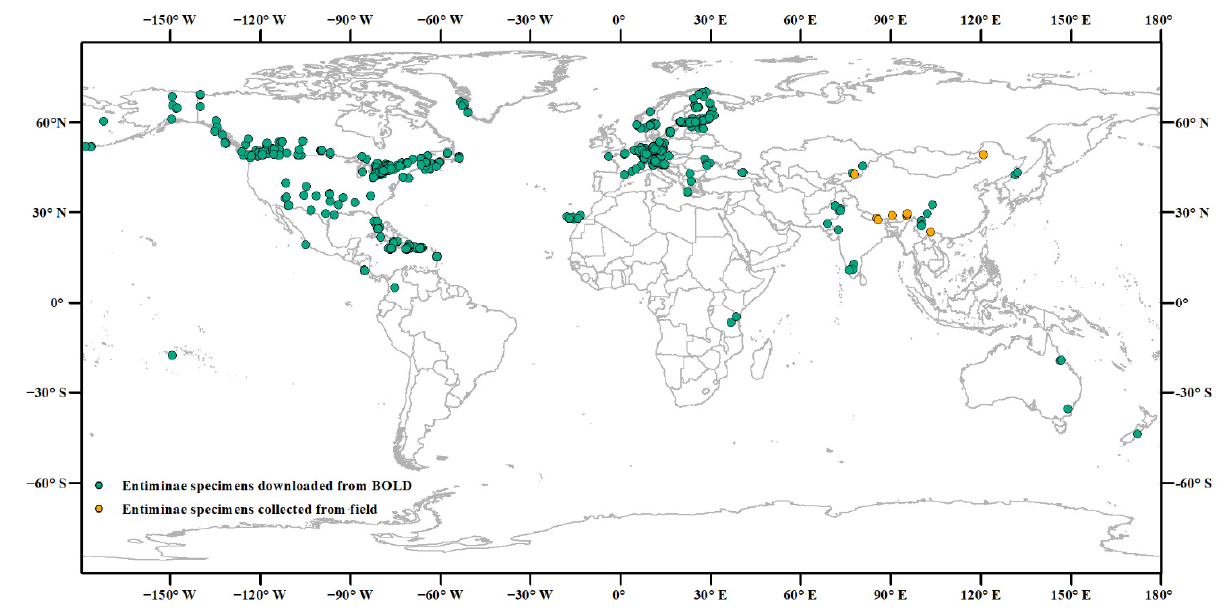
Figure 1. Sampling localities of Entiminae specimens for which COI barcodes were analyzed. The green and orange dots represent the samples downloaded from the BOLD database, and newly collected, respectively.